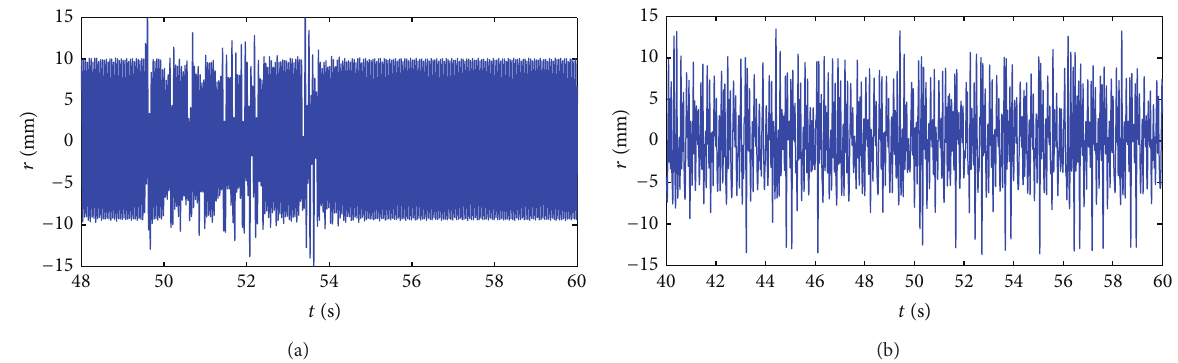
Figure 19: Experimentally obtained time series for 𝜔 𝑒 = 12 Hz with different 𝑍 𝑒 : (a) 𝑍 𝑒 = 2.2𝑔 and (b) 𝑍 𝑒 = 2.3𝑔 .